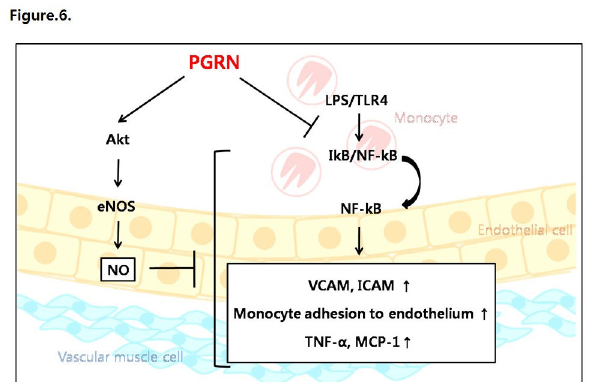
Figure 6. Schematic diagram of the progranulin (PGRN) mechanism in HUVECs. Progranulin activates (◊) the Akt/ eNOS/NO pathway and inhibits () LPS/TLR4-mediated pro- inflammatory